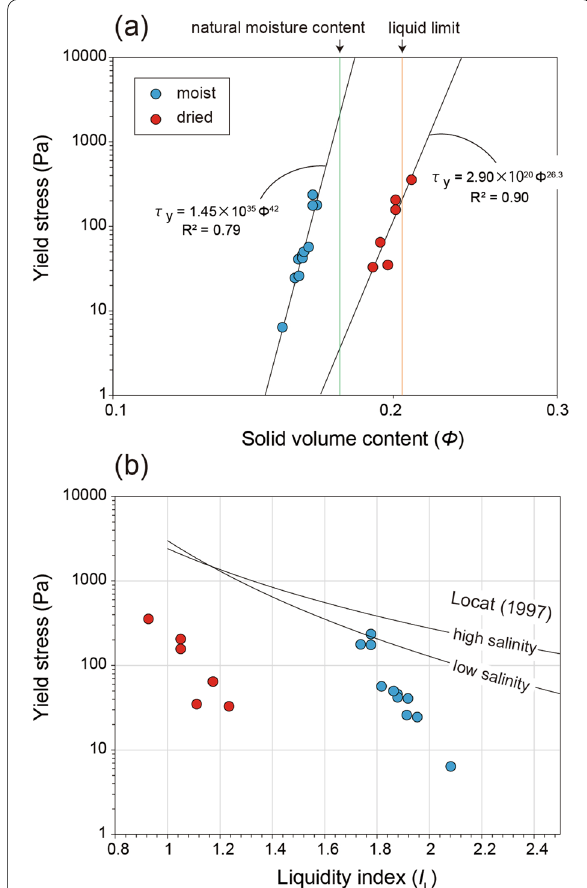
Fig. 5 a Yield stress versus solid volume content for slurries of moist (blue) and dried (red) soil with power-law fittings. b Yield stress versus liquidity index of each slurry. Empirical relations for several types of clay slurry are also shown (Locat 1997)